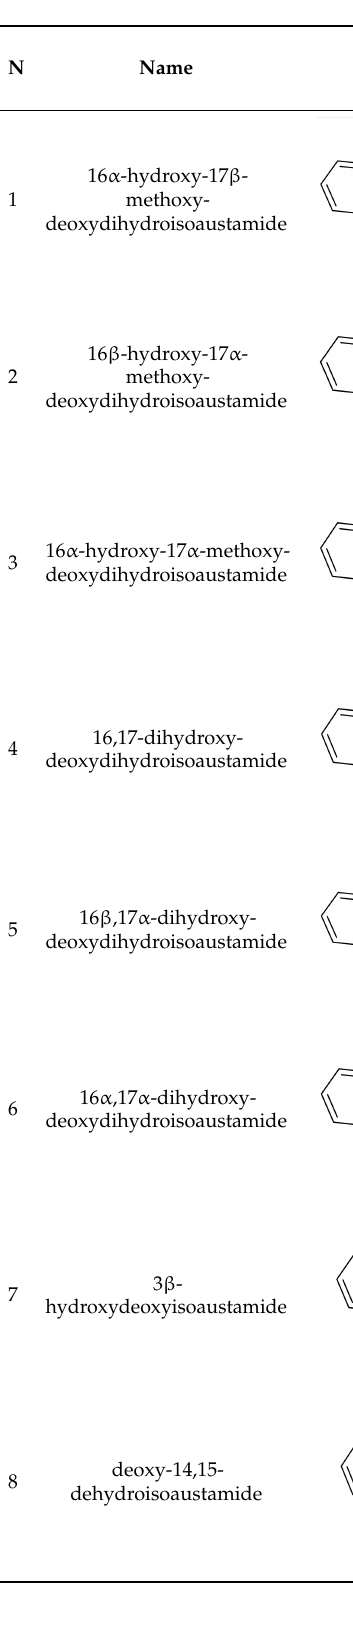
Table A1. The identified